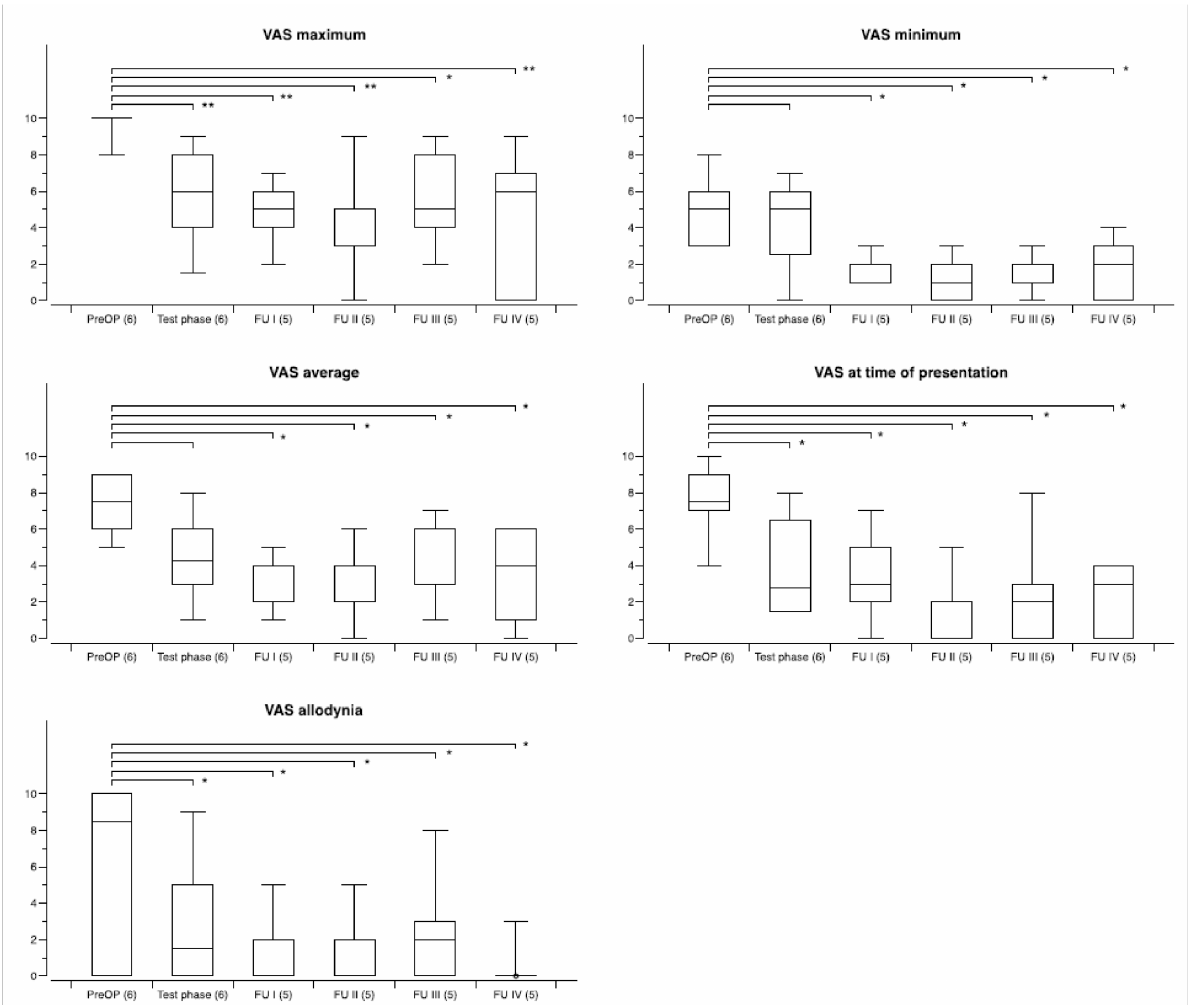
Figure 3. Development of specific VAS pain scores during chronic thalamic stimulation in a group of six patients with facial pain syndromes. The number of patients available at the different time points is shown in brackets. Follow-up examinations were obtained at FU I: 3–12 months postoperatively, FU II: 12–23 months, FUP III: 24–47 months, and FU IV: 48-and longer. Box and whisker plots of test results over time. Boxes represent the first, second (mean), and third quartile of scores. Whiskers outline the maximum and minimum. The level of significance for the different follow-up periods as compared to preoperatively is indicated by * (* p < 0.05; ** p < 0.01; *** p <